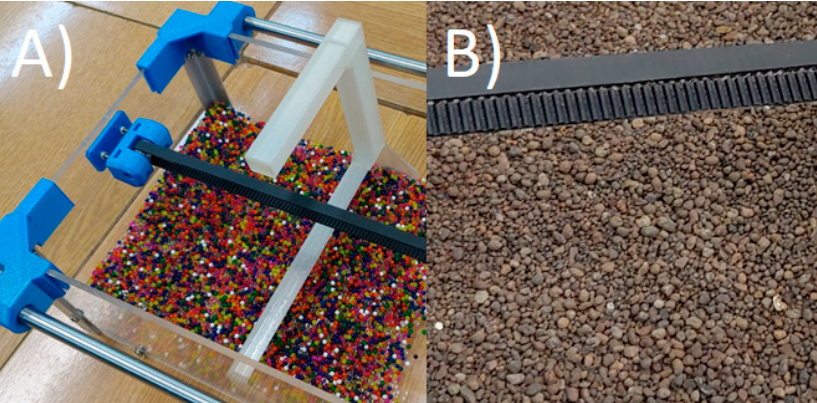
Figure 11. Test beds: ( A ) polymer particles during distribution, ( B ) expanded clay distributed soil. The whole process was repeated ten times for each case and the obtained results were averaged. Unfortunately, in many cases the material was jammed in the blades and the blades became immobilized. Investigations performed using FDM-produced harvester were unsuccessful. For both materials, the blades was jamming and tests were inter- rupted. The situation was much better when the SLA-produced body was used. However, the non-uniform expanded clay shapes still generated so much trouble that not a single 8 s experiment could be carried out without the blade jamming. Only by idealizing the ge- ometries so that they corresponded to the geometry from the DEM model, i.e., using pol- ymer balls with a diameter of 1–4 mm and a smooth body, was it possible to conduct a